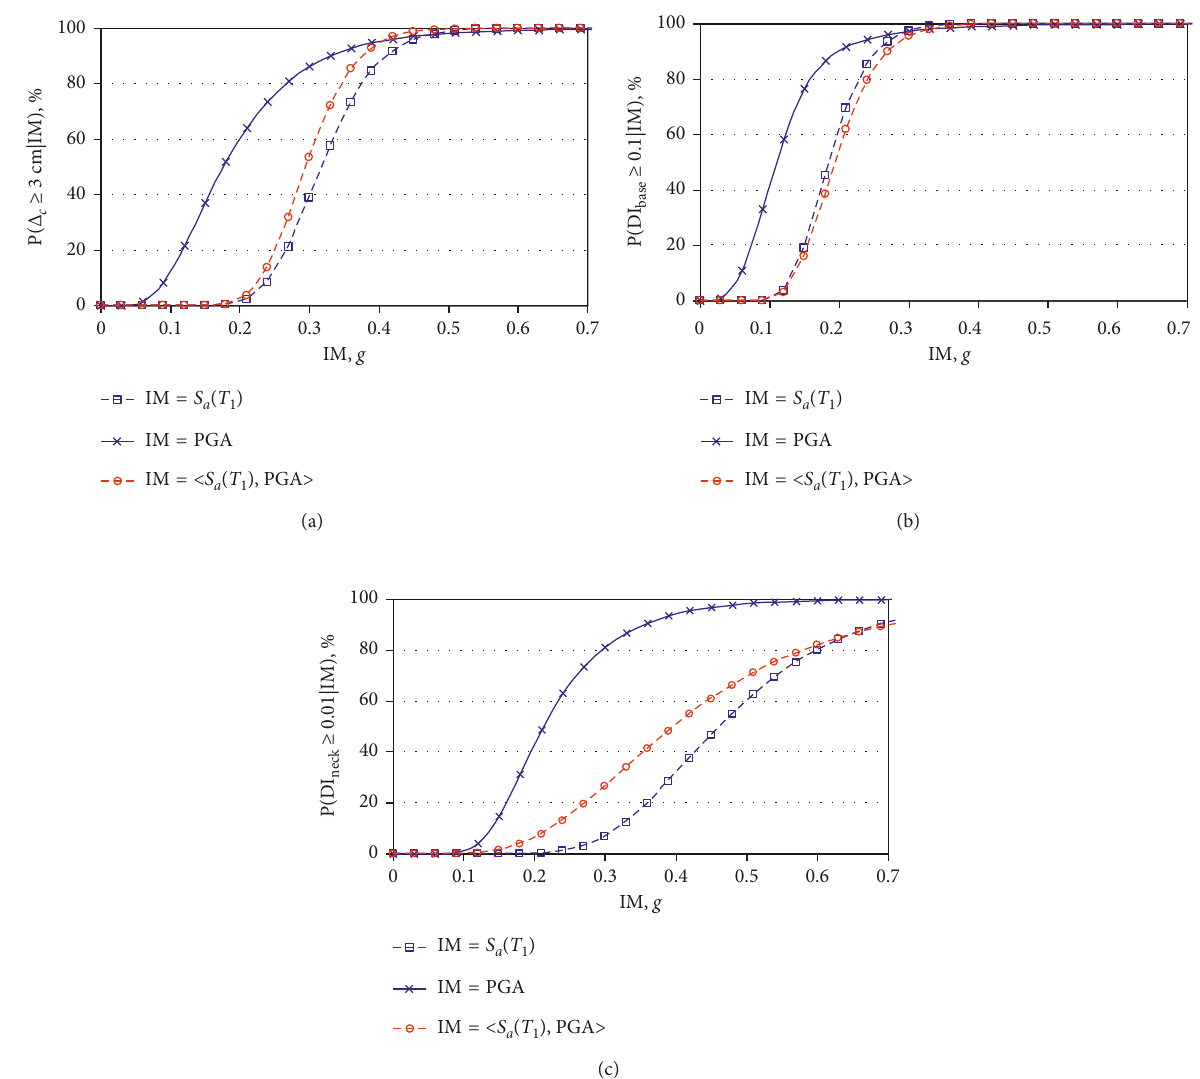
c ≥ 3cm, (b) DI base ≥ 0.1, and (c) DI neck ≥